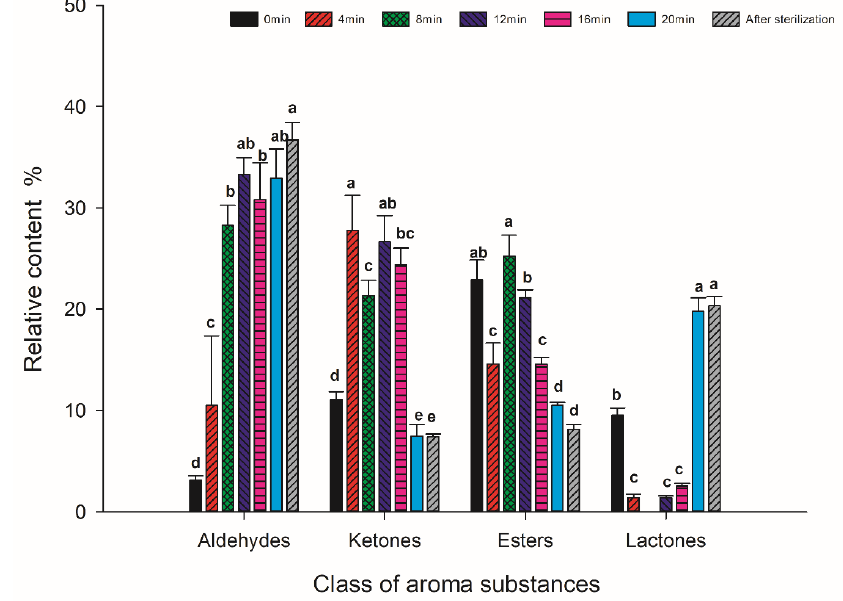
Figure 2. Relative contents of ester, lactone, alcohol and ketone aroma compounds for the coconut jam obtained by GC−MS. Values identified with different letters represent significant differences for each class of compound.